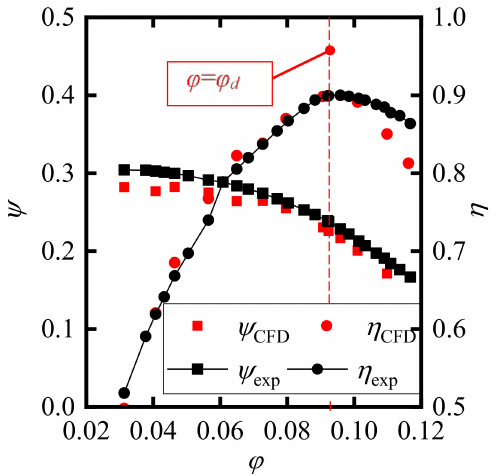
Figure 9. Comparison between CFD and experimental dimensionless head ψ and efficiency η .